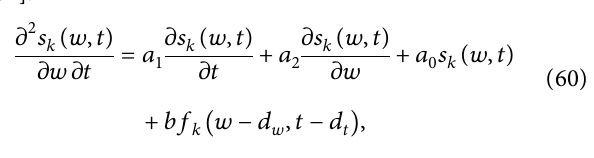
( n , n ) for n 􏼈 􏼉 20 􏼈 􏼉 20 and n . r 1 2 1 2 0 0 Figure 6: Tracking error index MATE using the ILC law